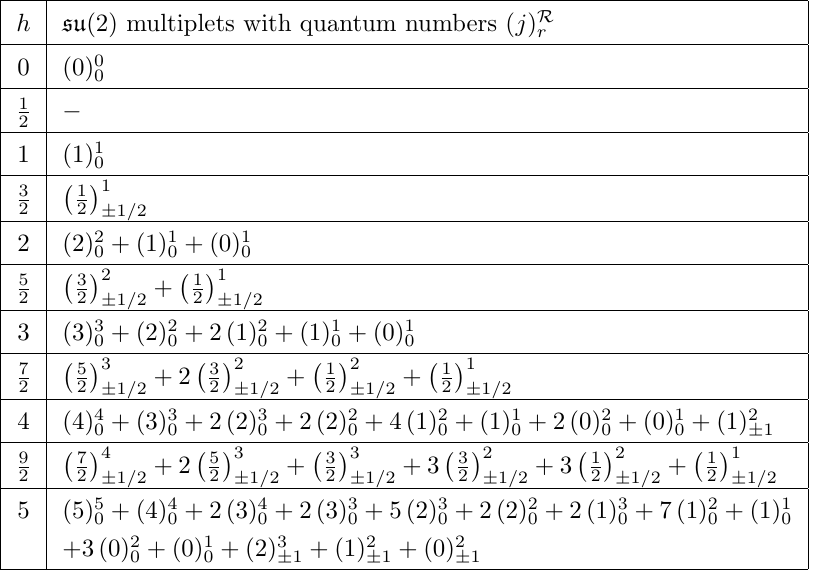
Table 5 . States in the VOA W (cid:0) with (cid:0) = A 1 with h (cid:20) 5. The notation ( j ) R under the sl (2) y symmetry of the small N = 4 SCA, the outer automorphism quantum number r , and the R -weight. When we write, for instance, and r = (cid:0) 1 = 2 are found with the same multiplicity.